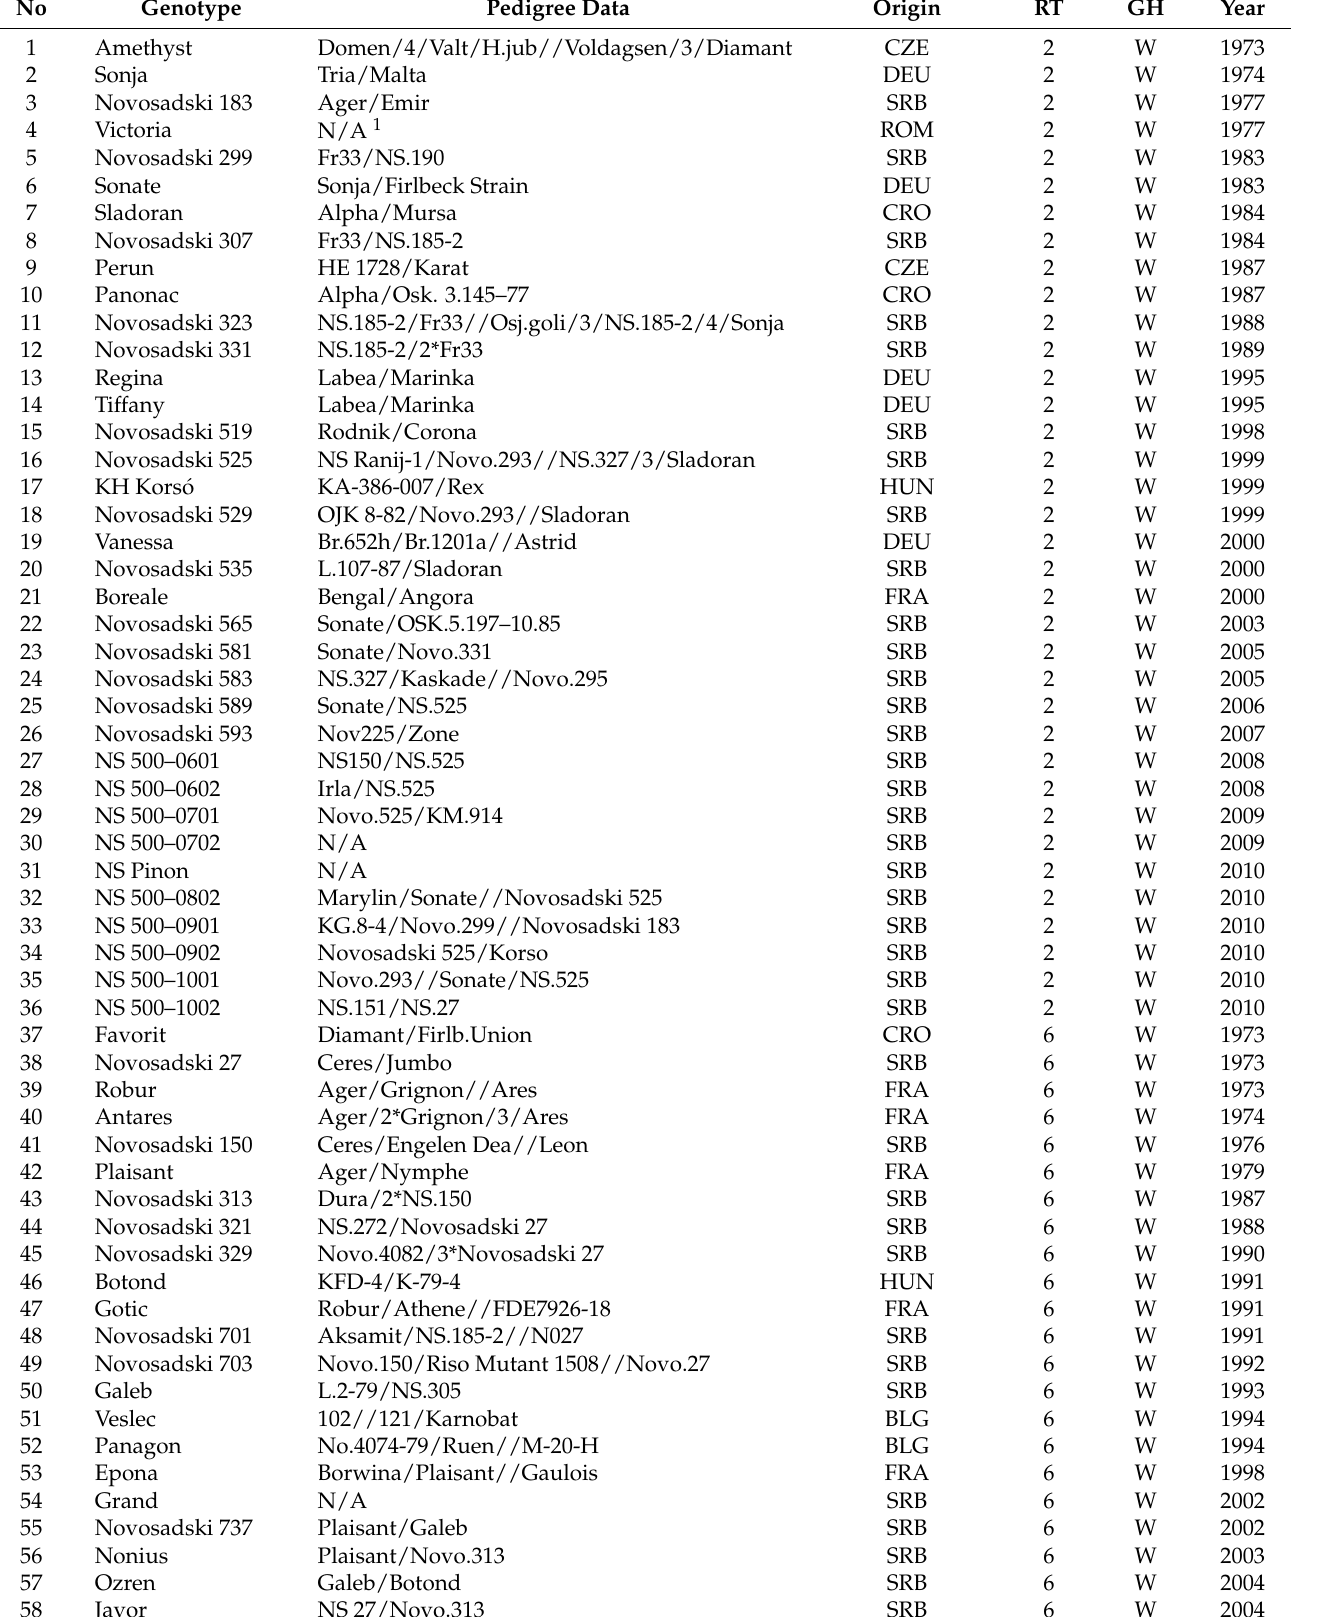
Table 1. Names, pedigrees, country of origin, row type, growth habit, and the year of release of the 90 barley